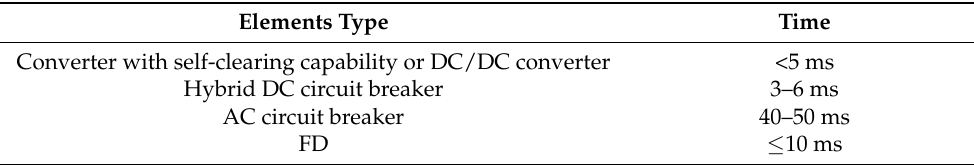
Table 1. The action time of fault-clearing